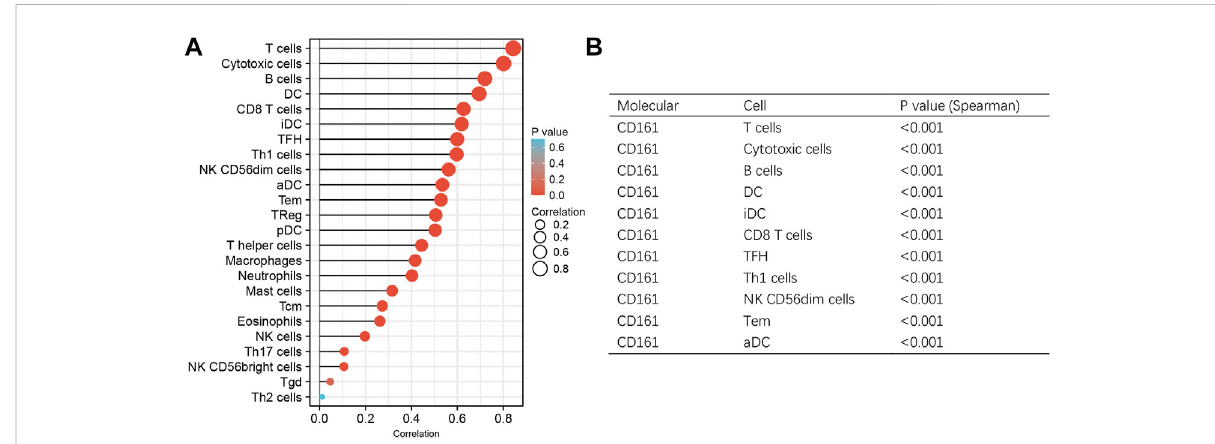
FIGURE 7 ssGSEA analysis to evaluate the correlation between CD161 expression and the immune in fi ltration in BC. (A) The Lollipop chart showed the associationbetween CD161 expressionand24kindsofimmunecells. X -axis:Spearman ’ srho. Y -axis:24typesofimmunecells.Thecolorgradientof the lollipop referred to the correlation p -value, and the size of the lollipop referred to the correlation strength. (B) The Spearman ’ s correlation > 0.5 and p < 0.05 groups were exhibited in the trilinear